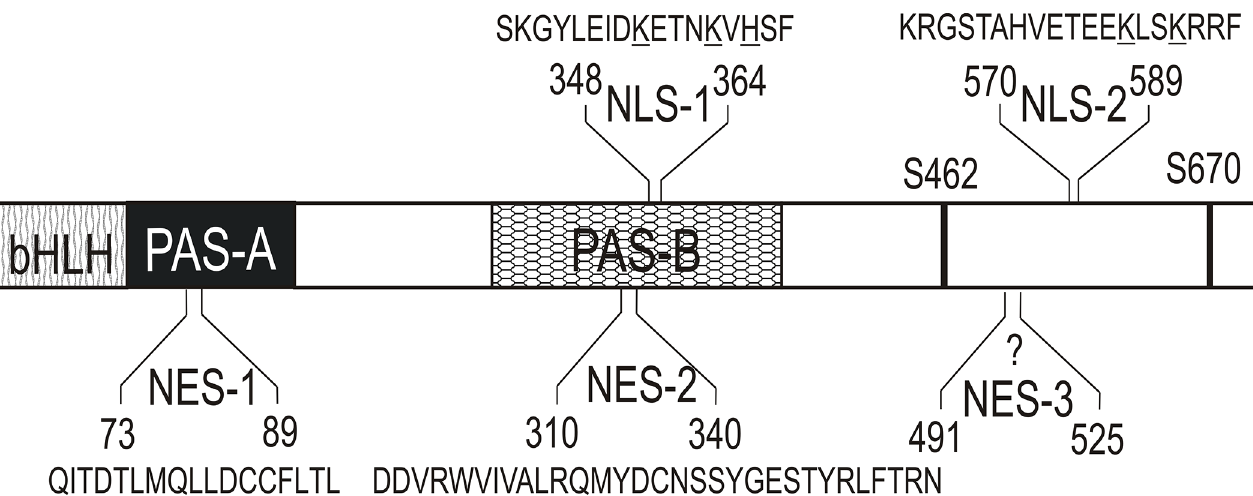
Fig 6. Schematic representation of NLS and NES signals residing within the GCE protein. Distribution of the NLS-1, NLS-2, NES-1, NES-2 and a putative NES-3 signals identified in the GCE protein. Specific domains of the GCE are marked with different graphic patterns according to Fig 1A. Residue numbering corresponding to the sequence of the GCE used in this study is given at the top and at the bottom of the sequences encompassing the NLS and NES